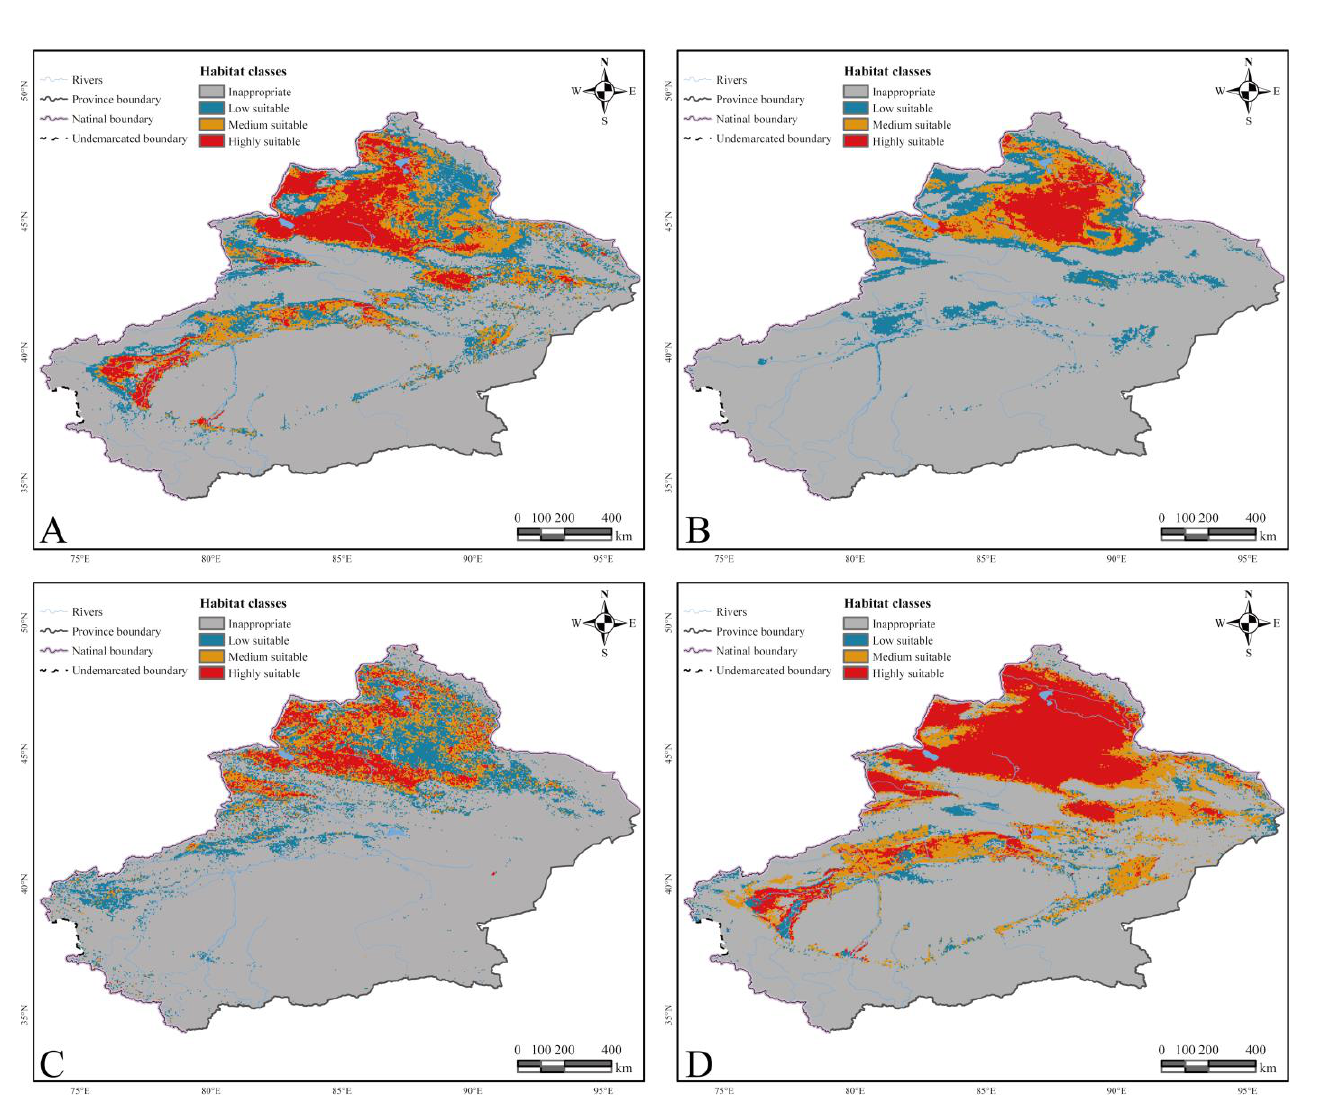
Table 3. The niche range overlap values of hosts and two strategies; threshold value is 0.65. Category